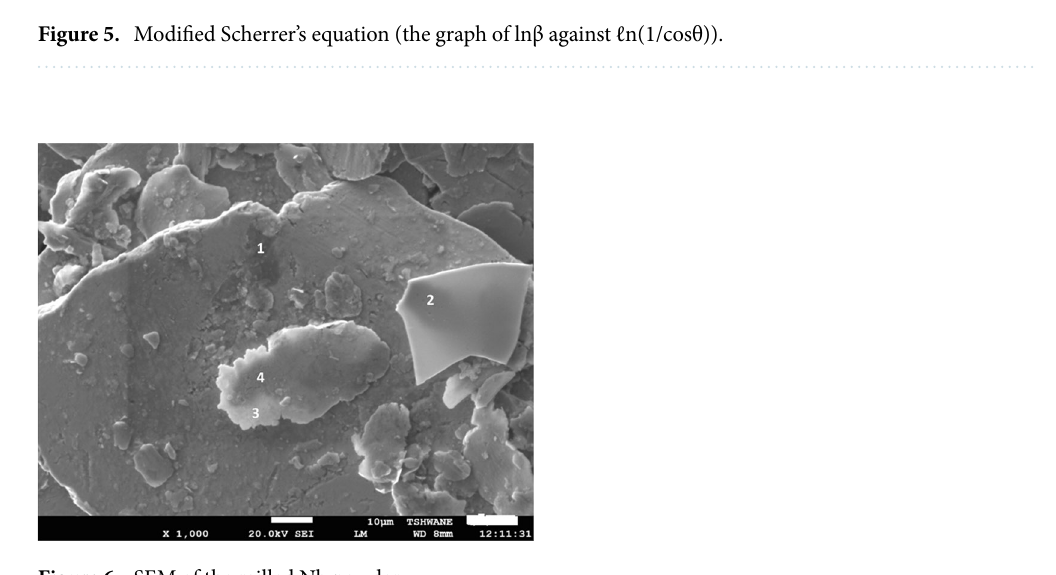
Figure 6. SEM of the milled Nb